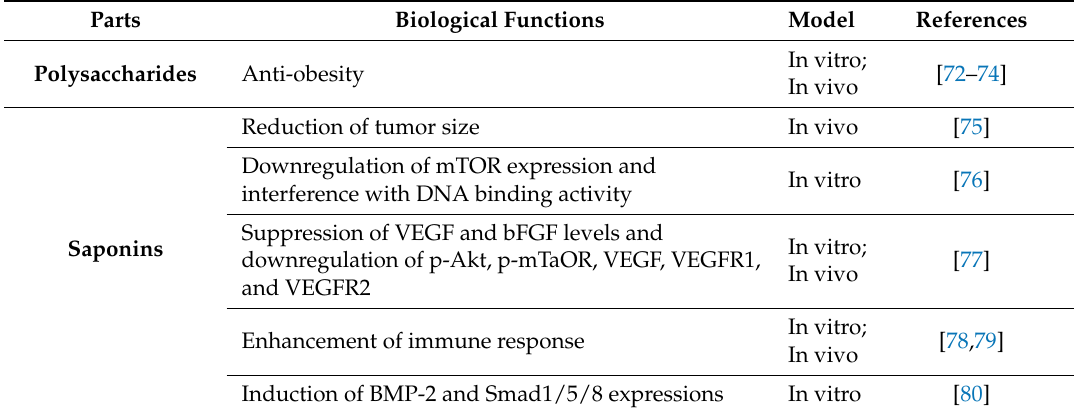
Table 3. Other functions of AR and its major